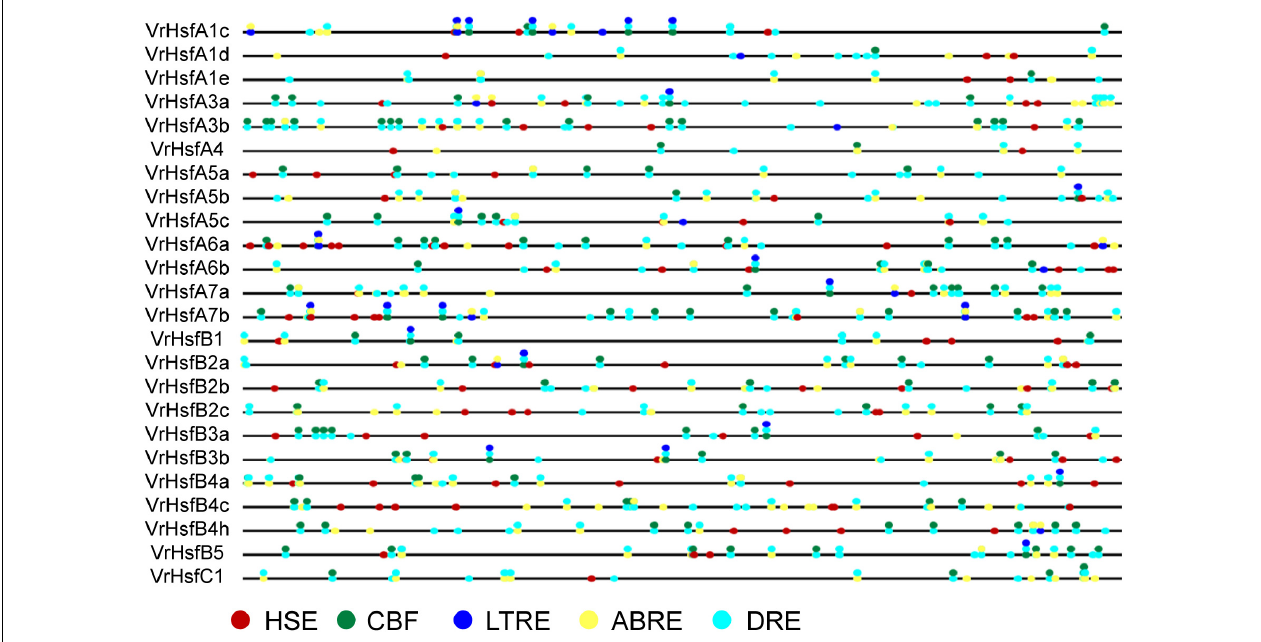
FIGURE 5 | Cis -element analysis of VrHsf promoters 2 kb upstream of the translation initiation codons. Different colored circles indicate different response elements. HSE, Heat Stress Element; CBF, C-Repeat Binding Factor; ABRE, ABA Responsive Element; DRE, Dehydration-Responsive Element; LTRE, Low Temperature Responsive